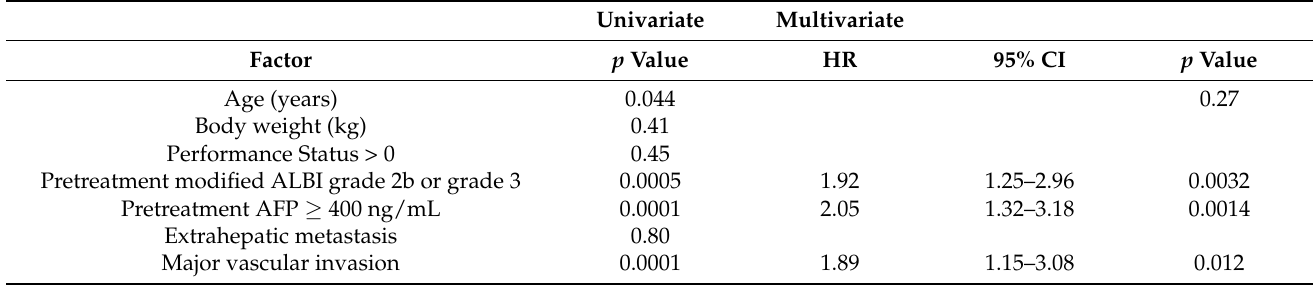
Table 6. Factors associated with mortality in lenvatinib therapy (MTT naïve patients).